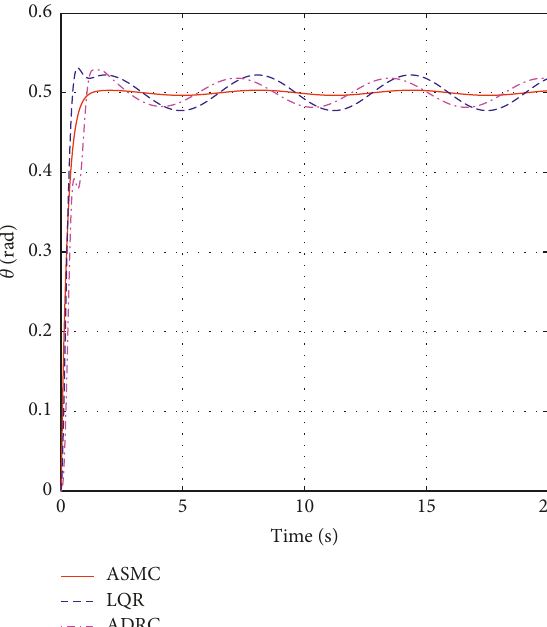
Figure 8: The tracking performance of pitch angle.